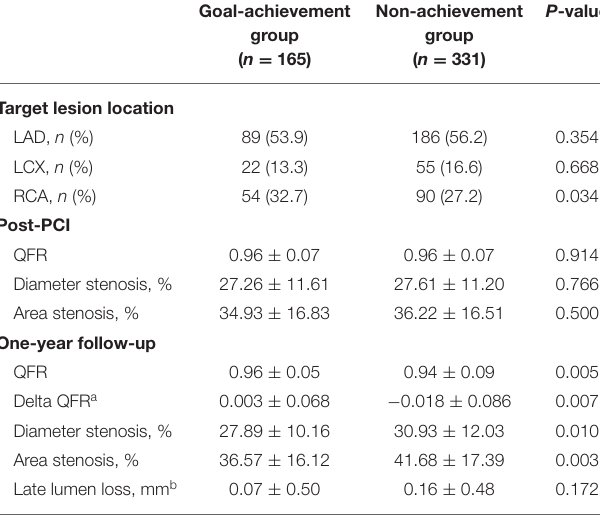
TABLE 3 | QCA and QFR analysis results.